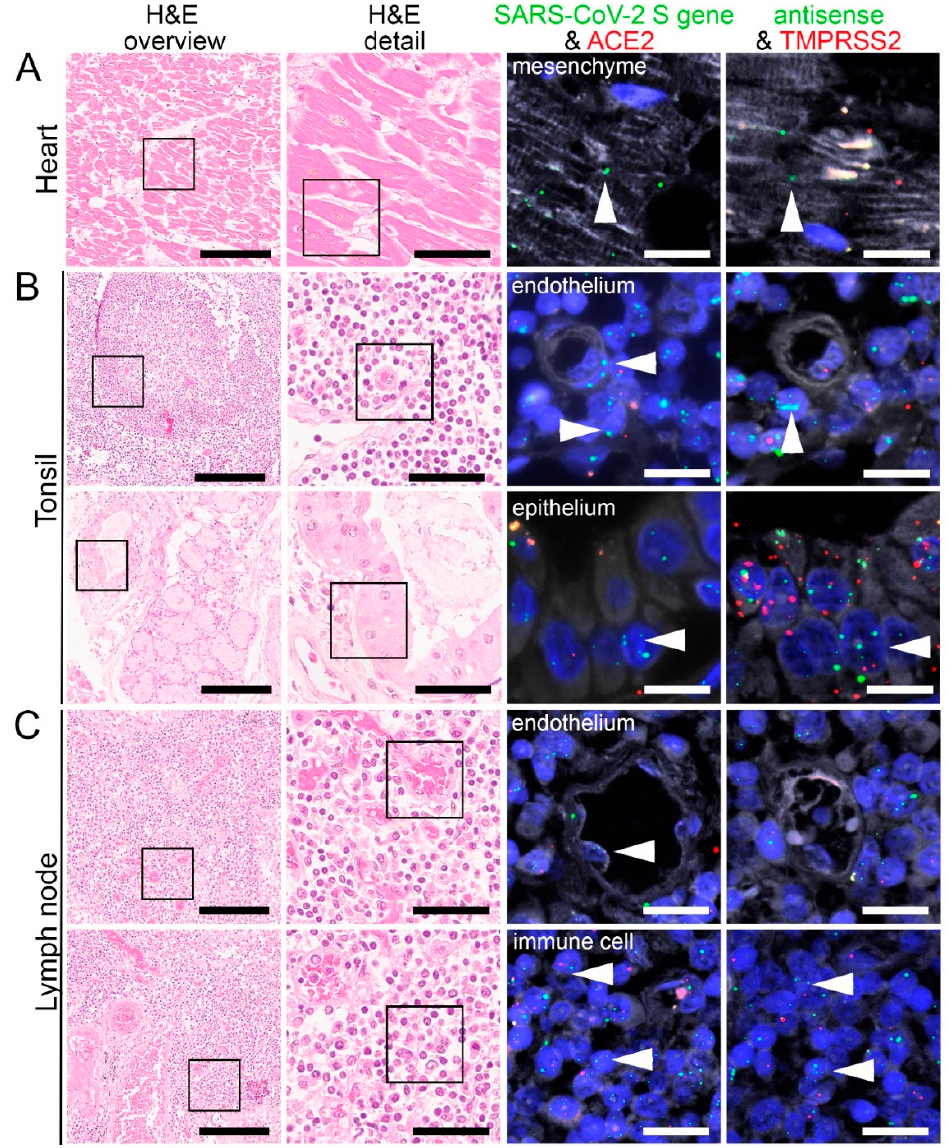
Figure 5. Virus detection in heart and lymphoid organ autopsy tissue by FISH. HE stained tissue and representative image sections showing FISH co-visualization of RNA sequences either of SARS-CoV-2 S gene genomic RNA (green, arrowhead) and ACE2 (red) or SARS-CoV-2 antisense strand RNA indicating replicating virus (green, arrowhead) and TMPRSS2 (red) in the heart ( A , cardiomyocyte), tonsil ( B , upper panel: capillary with endothelial lining, surrounded by lymphocytes/immune cells; lower panel: local small salivary gland epithelium) and lymph node ( C , upper panel: capillary with endothelial lining; lower panel: lymphocytes/immune cells). Scale bars represent 200, 50 and 20 µm, respectively.